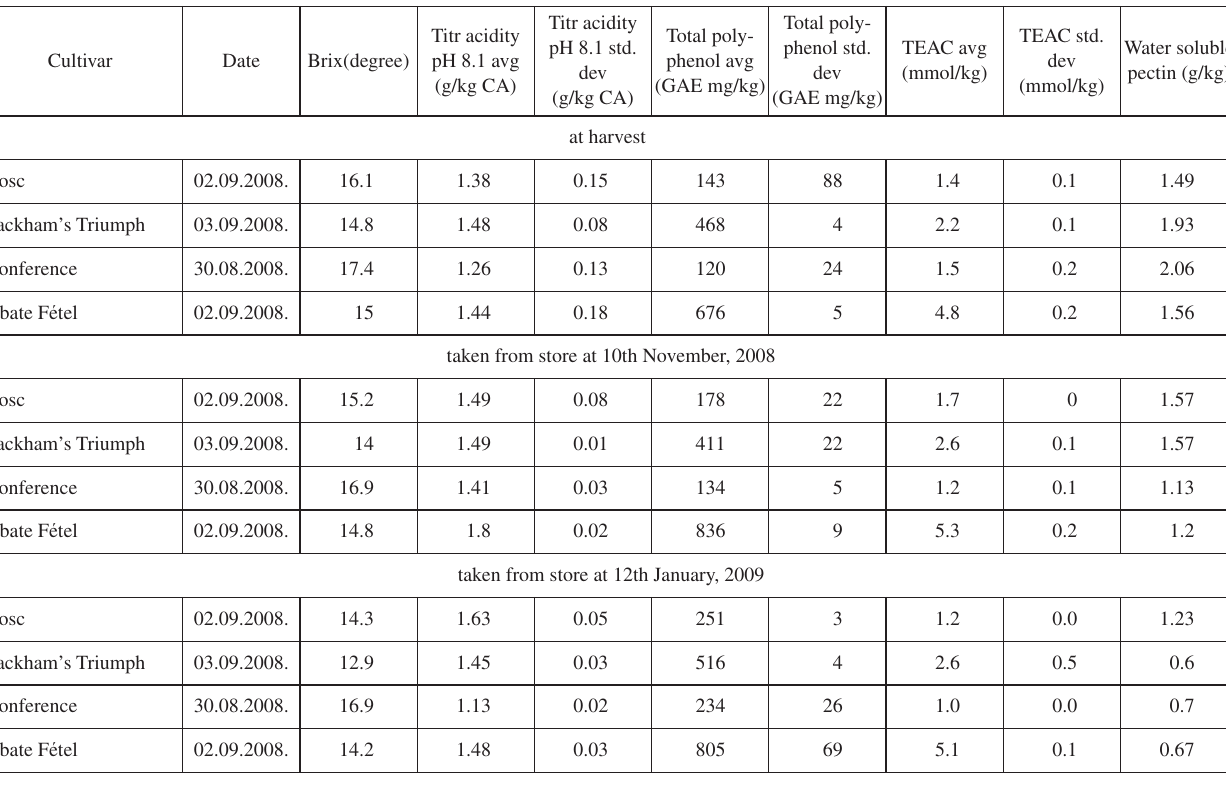
content is interesting, as the AIJN Code of Practice gives an upper limit of 15 g/kg for 100% pear puree. All the sugars measured by our team are much higher (often double) than the values of Hudina and Štampar (2000) found in Slovenian grown fruits. The content of water soluble pectin present in pears changed from 0.43 (‘Williams’ 2009) to 2.06 g/kg (‘Conference’, 2008). Total polyphenol content and free radical scavenging activity was excellent in ‘Abate Fètel’ variety, followed by ‘Packham’s Triumph’, the maximum total phenol is 836 mg/kg fresh weight. The measured polyphenol content is a bit less than the results of Leontowicz et al. (2002), who found about 2 g/kg for peeled pear and about 4 g/kg for peel.